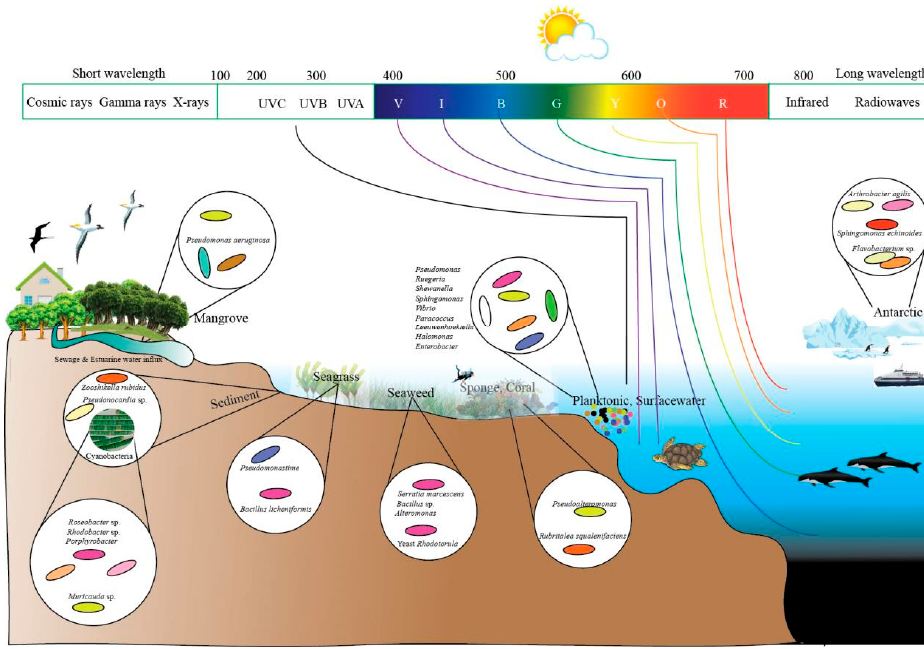
Figure 2. Distribution of marine pigmented microorganisms in di ff erent